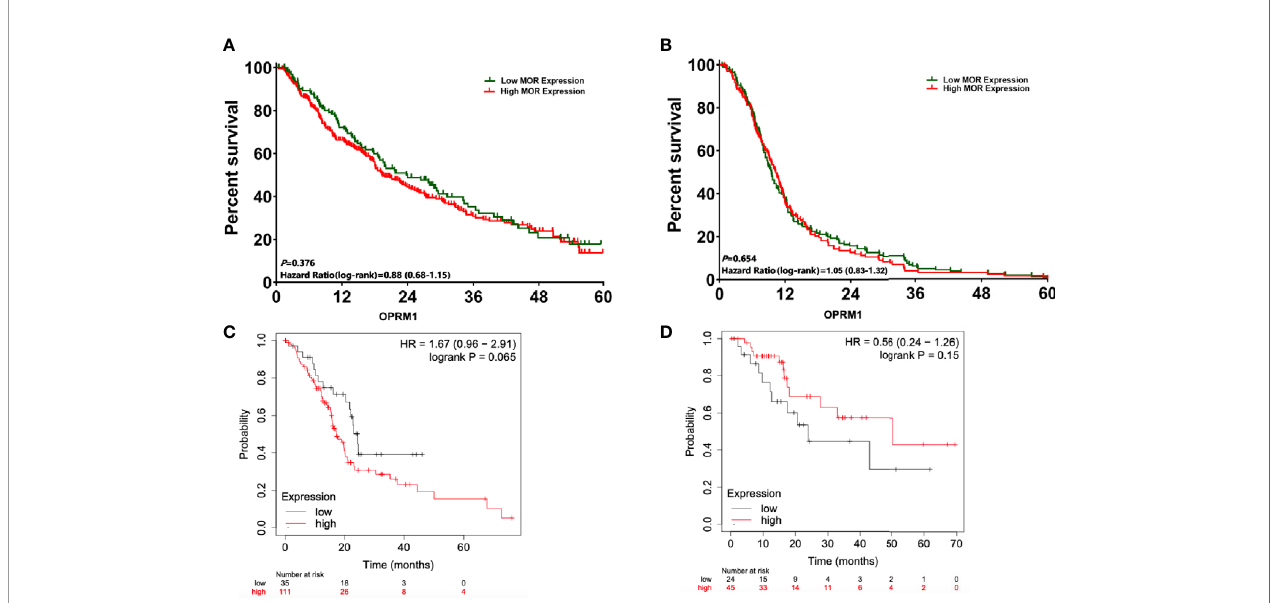
FIGURE 3 | Survival analysis from the date of pancreatic cancer surgery according to expression of MOR and OPRM1. (A) OS analysis according to MOR expression; (B) DFS analysis according to MOR expression; (C) OS curves according to expression of OPRM1 from the cancer database; (D) DFS curves according to expression of OPRM1 from the cancer